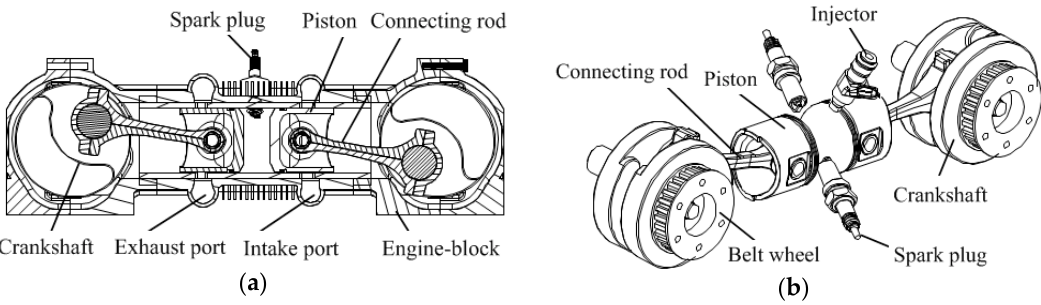
Figure 1. Configuration of OP2S gasoline engine ( a ) Section of OP2S gasoline engine; ( b ) Opposed crank-connecting rod mechanism. Table 1. Engine specifications.